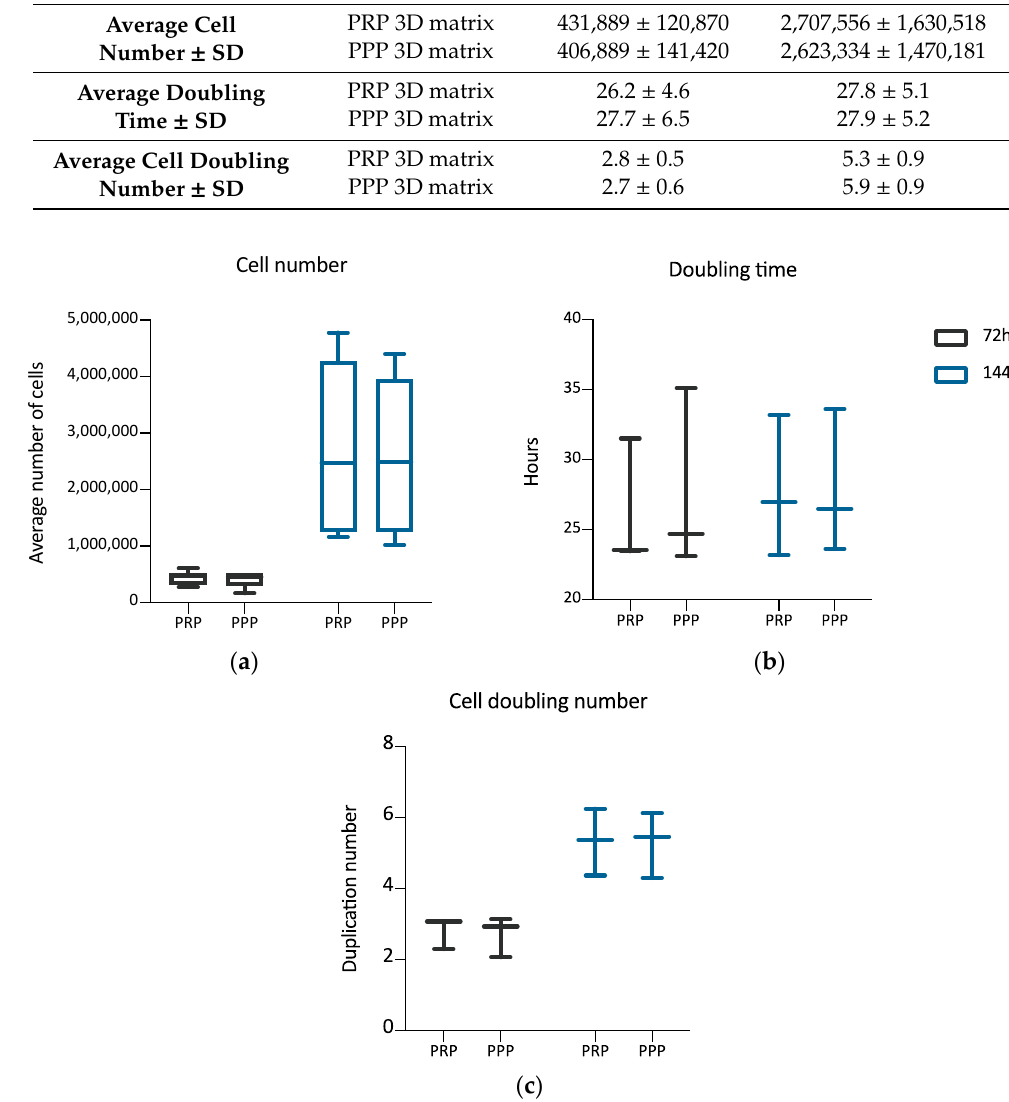
Figure 4. Box plot illustrating differences in average cell number ( a ), cell doubling time ( b ), and cell doubling number ( c ) of cells maintained inside a 3D matrix prepared from PRP or PPP, at different time points (72, 144 h) (n = 3). No statistically significant differences are observed between the two culture conditions. Table 2. Average cell number, doubling time and cell doubling number obtained at different time points (72, 144 h) from ADMSCs cultured inside a 3D fibrin-based matrix prepared from PRP or PPP (n = 3).